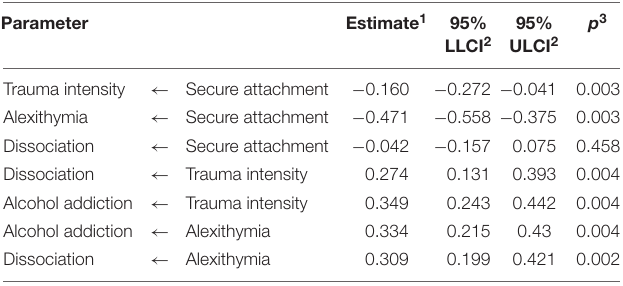
TABLE 5 | Standardized estimates with 95% confidence intervals for models taking into account the secure attachment style.